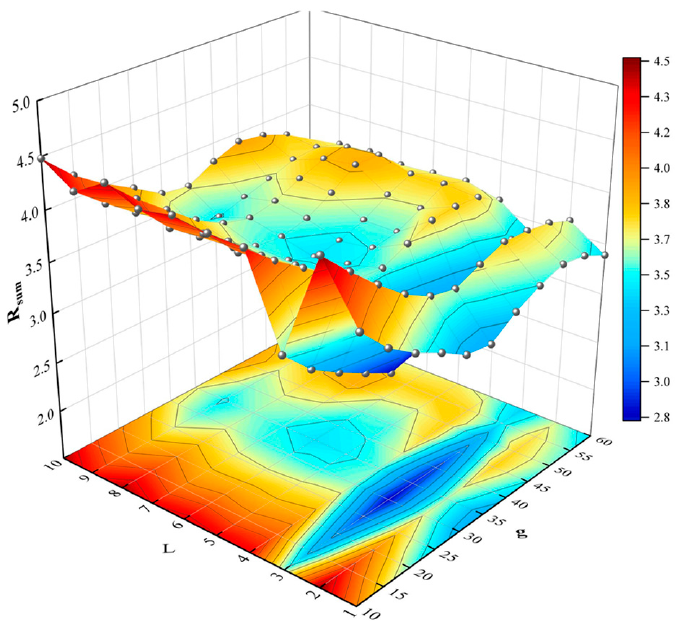
Figure 7. Rsum for various values of 𝑔 and 𝐿 . Figure 7. R sum for various values of g and L